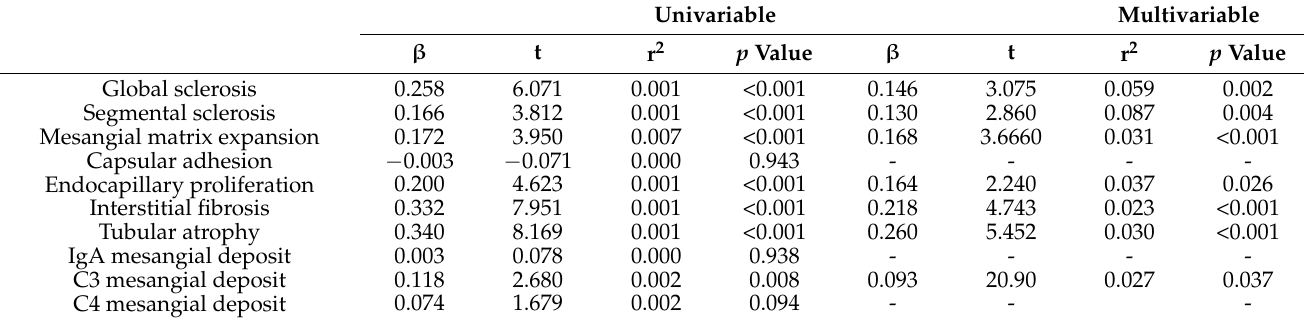
Table 4. Linear regression for uric acid and the histopathologic parameters in all